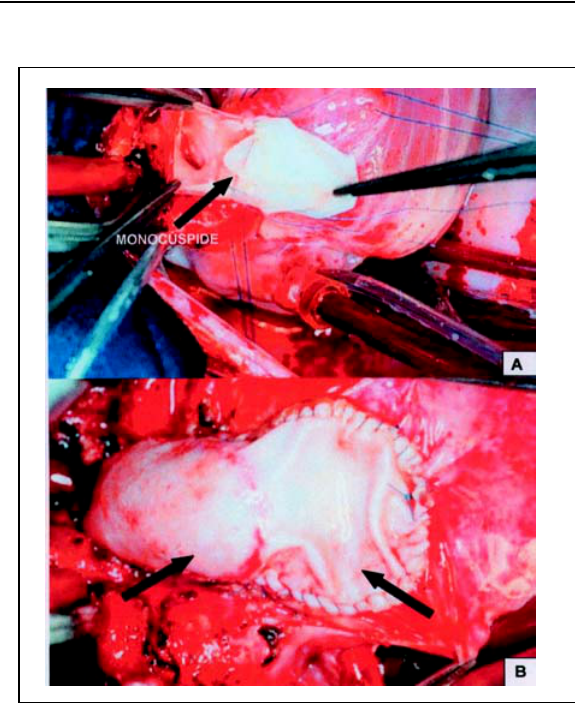
Fig. 7 - Monocúspide de pericárdio bovino utilizada para ampliação da via de saída do ventrículo direito. A - Aspecto interno. B - Aspecto externo onde se pode observar competência da válvula monocúspide.